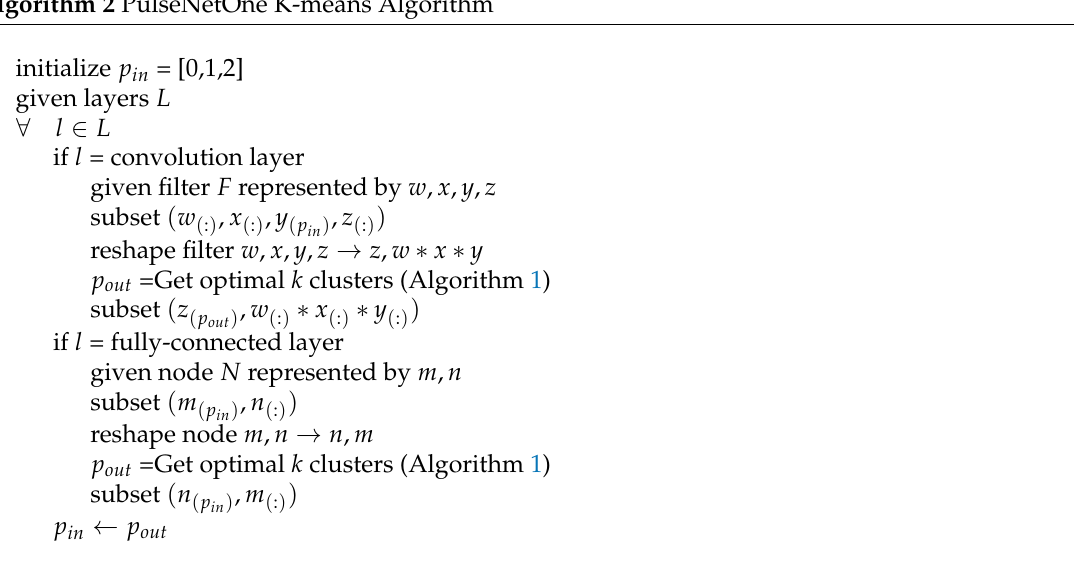
Algorithm 2 PulseNetOne K-means